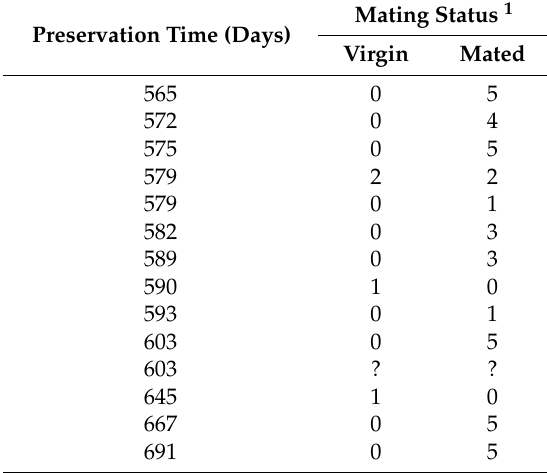
Table 2. Efficiency of the protocol for determining the mating status of Drosophila suzukii females reared in the laboratory from infested raspberries. Mating Status Parameters Total Number of Flies Virgin Mated Number of flies per treatment 10 Data comparisons (Correctly identified virgin vs. mated